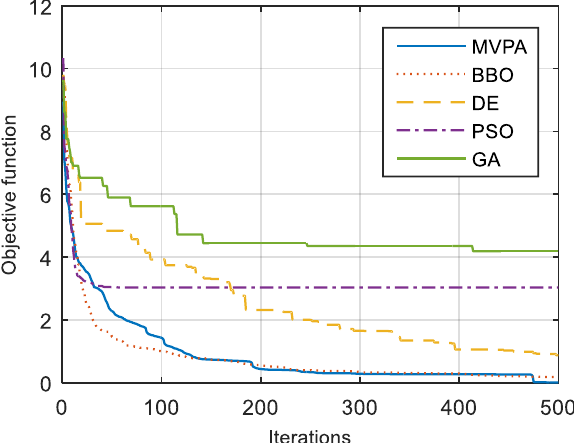
Figure 5. Evolution of the objective function versus iterations for case 2. Table 2. Comparison of actual locations with those obtained using different algorithms for case 2.